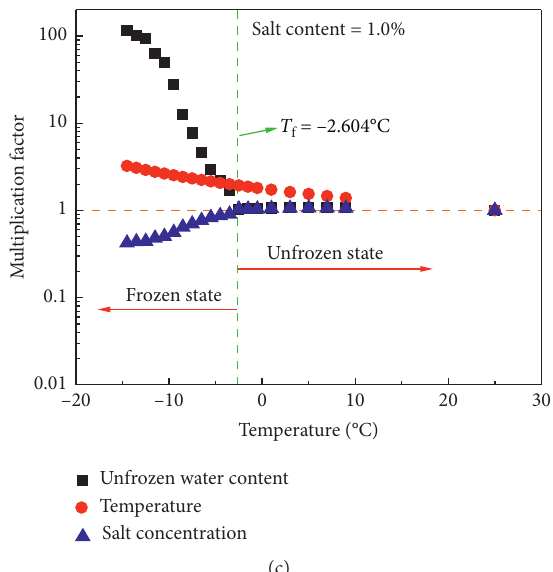
Figure 9: The variation of multiplication factors with temperature during freezing. (a) Without salinity. (b) Salinity of 0.2%. (c) Salinity of